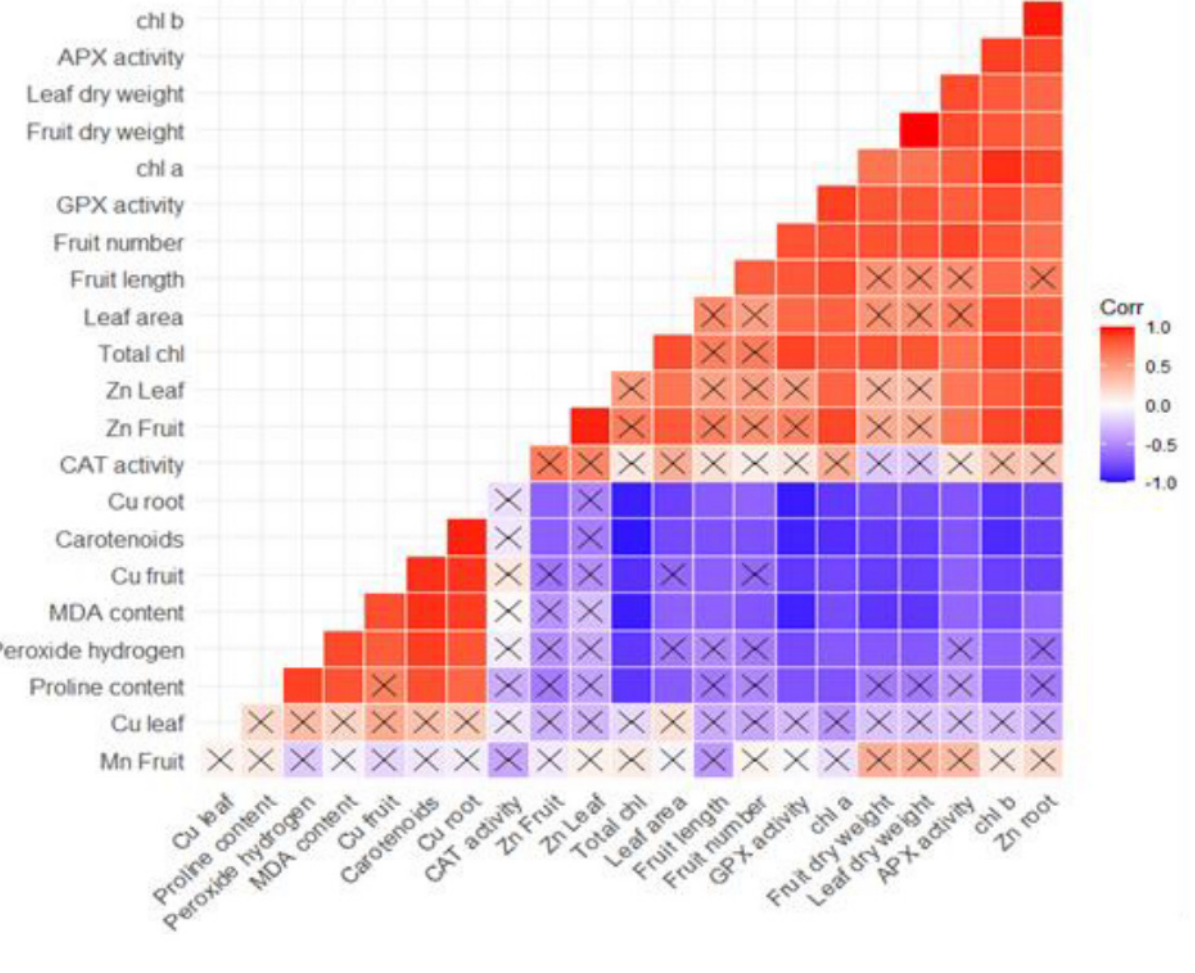
Figure 4. Heat-map plot showing Pearson correlation intensities between measured characteristics. The sign × stands for statistically insignificant correlations.